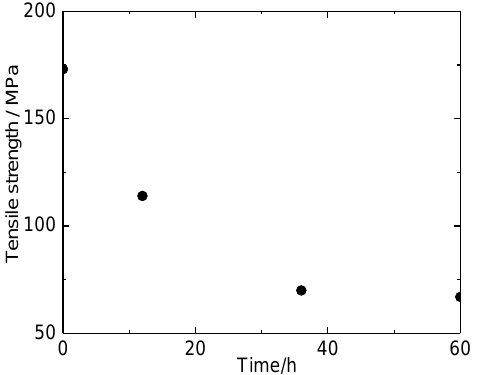
Figure 3. Strength of carbon-fibre/aluminium-matrix composite versus the annealing time at 600°C. After experimental data published in [20].